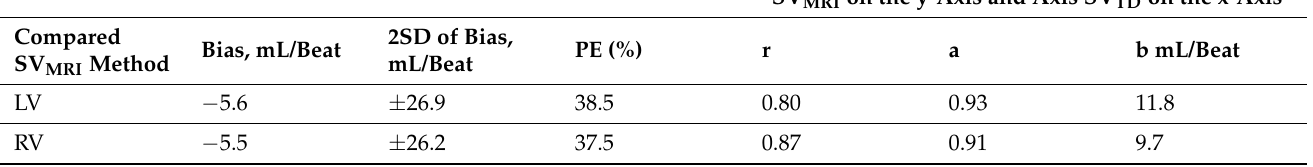
Figure 3. Bland and Altman analyses of SV MRI against SV TD . LoA are in grey and black. Bias is in orange. Results are in stroke volume (mL/beat). AAO: ascending aorta, DAO: descending aorta, LV: left ventricle, LPA: left pulmonary artery, PA: pulmonary artery, RV: right ventricle, RPA: right pulmonary artery, TD: thermodilution, SVC: superior vena cava. Table 4. Comparison between the six different SV MRI methods against SV TD . Linear Regression with Coefficient of Bland and Altman Analysis Correlation (r), Slope (a), and Intercept (b) with SV MRI on the y-Axis and Axis SV TD on the